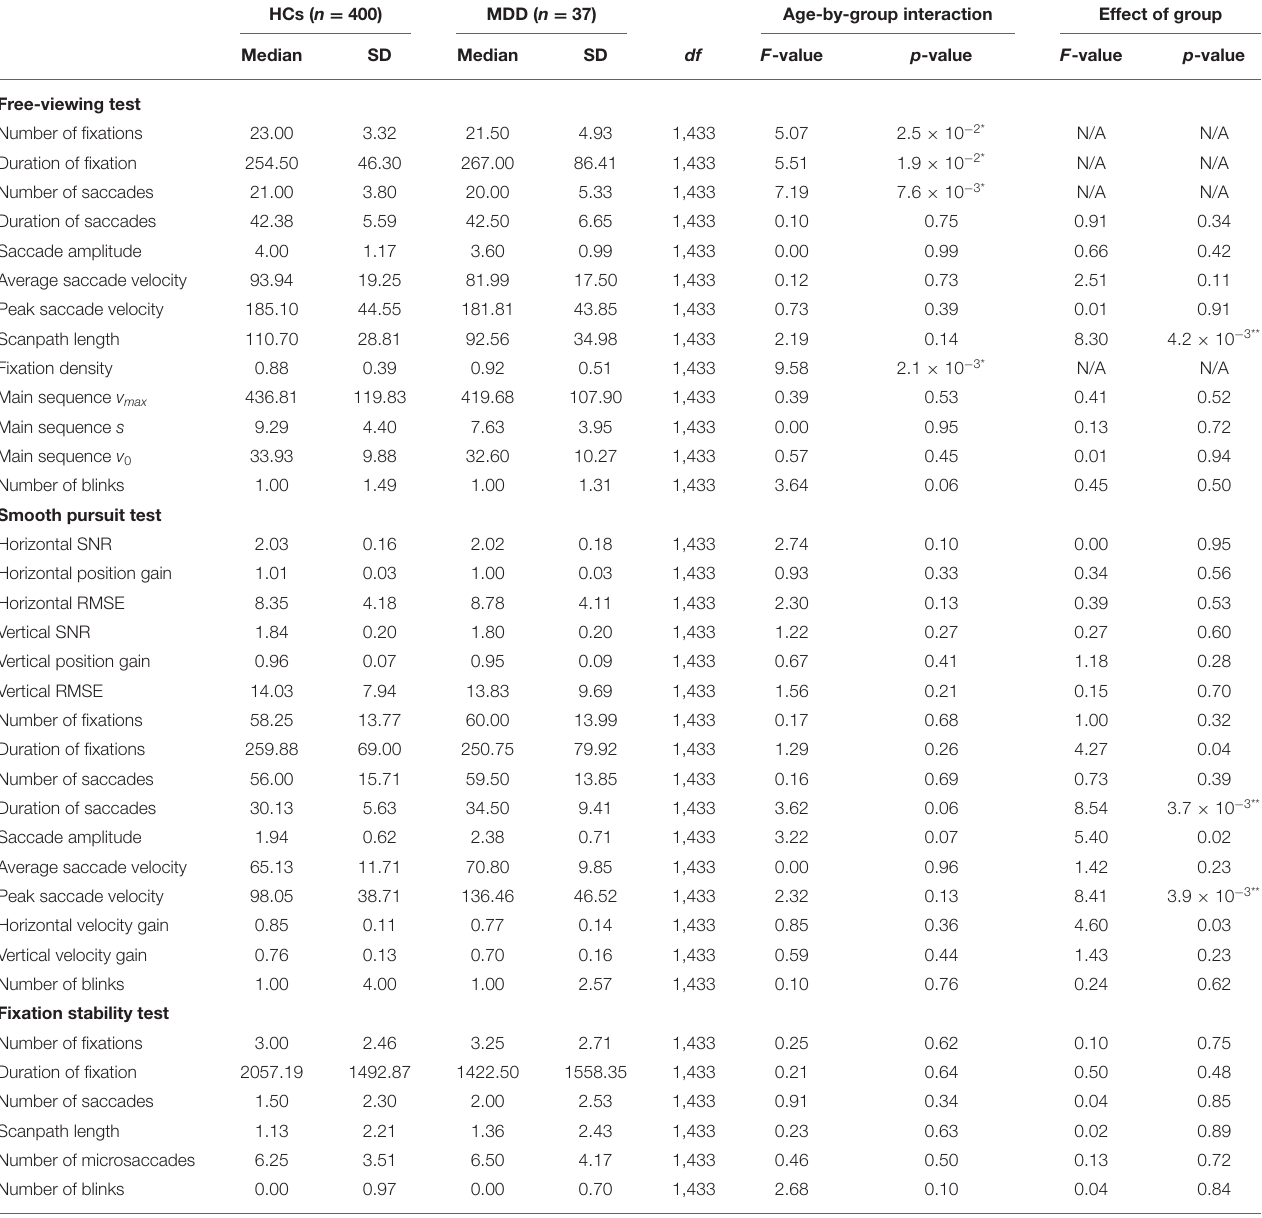
TABLE 3 | Results of